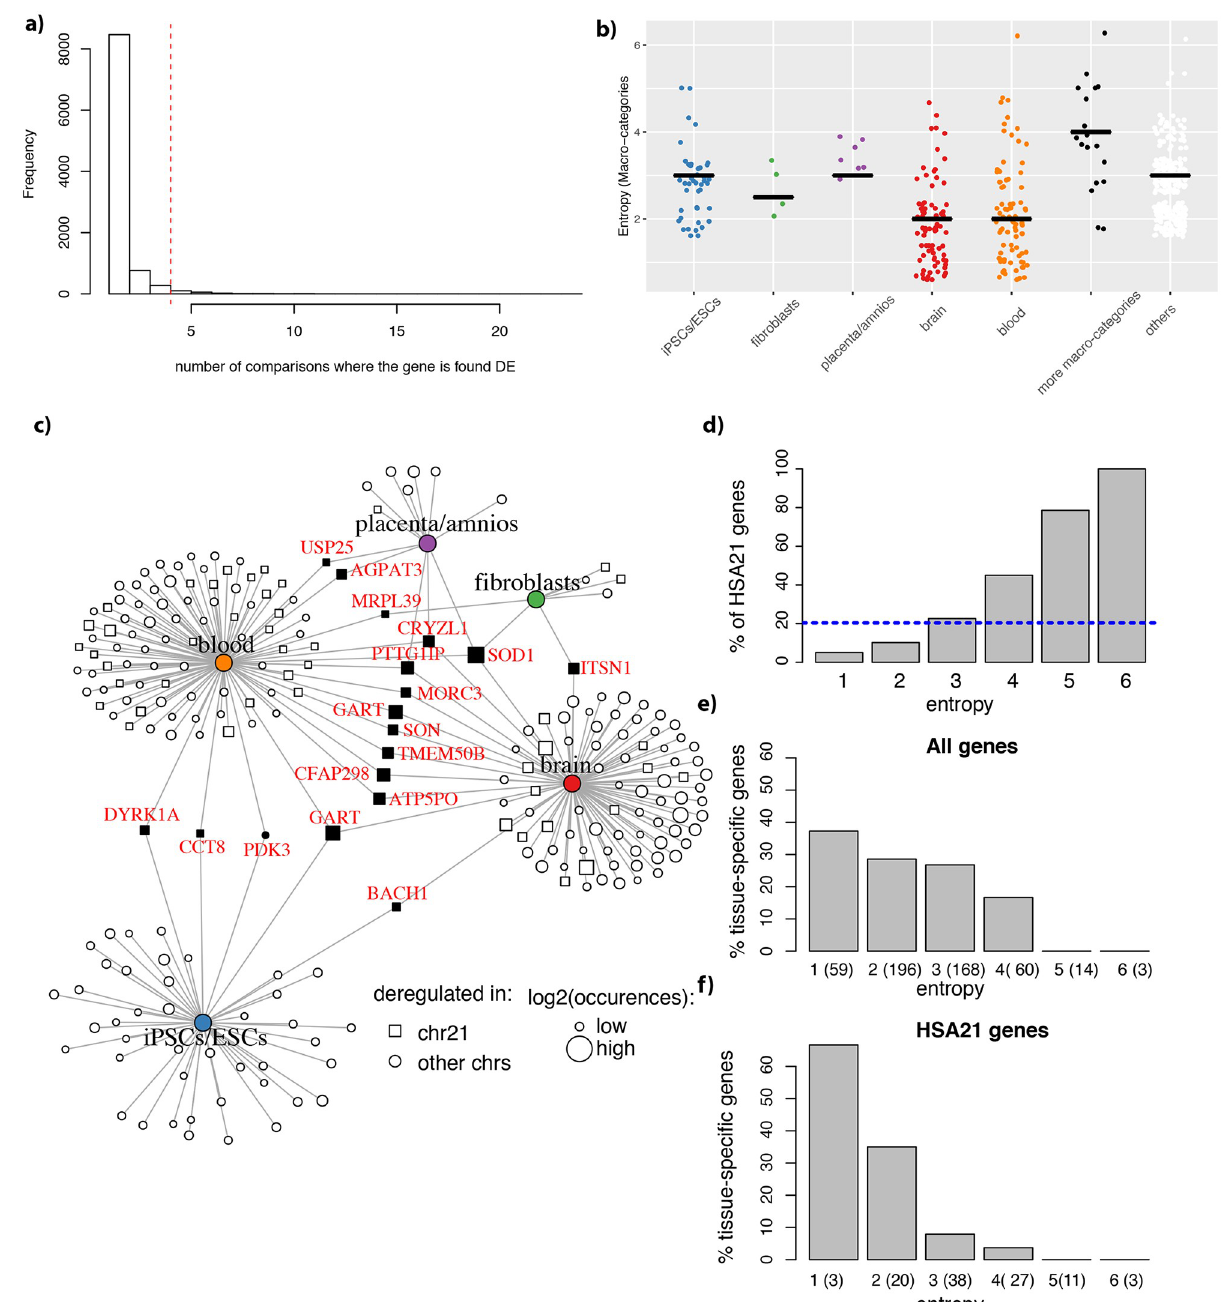
Fig 2. Tissue macro-categories show both HSA21 and non-HSA21 genes that are consistently DE. a) Histogram of DE genes’ occurrences. Genes in the right 5% are in the right of the red dot line, corresponding to genes found DE in at least 4 comparisons b) Entropy distribution across consistently DE genes. Each dot is a gene, the horizontal bar indicates the median entropy for each group. All genes consistently DE in iPSCs/ESCs were also found DE in at least another macro-category up to 4 other macro categories. Gene consistently DE in fibroblasts were also found DE in one or two macro- categories. Similarly, genes consistently DE in placenta/amnios were found DE also in 2 or 3 other macro categories. For brain and blood tissue we did detect a fraction specifically DE only in one of the two macro-categories, however, also in this case we detected genes DE in more macro-categories (1 to 4 for brain; 1 to 5 for blood). In black are genes that are consistently DE at the tissue level in more than one macro-category. In white, genes that are not consistently DE in any specific macro categories but are consistently DE across tissue. c) Bipartite graph showing the tissue macro-categories where we could find consistently DE genes at the tissue level. For each tissue macro-category, we plotted the frequency of the number of occurrences. The red dotted line indicates the minimal number of occurrences chosen for a gene to be DE in a given tissue macro-category. Genes mapping on HSA21 are represented by squares, otherwise by circles. Node size is proportional to the log 2 of the number of occurrences across all comparisons. Of note, most